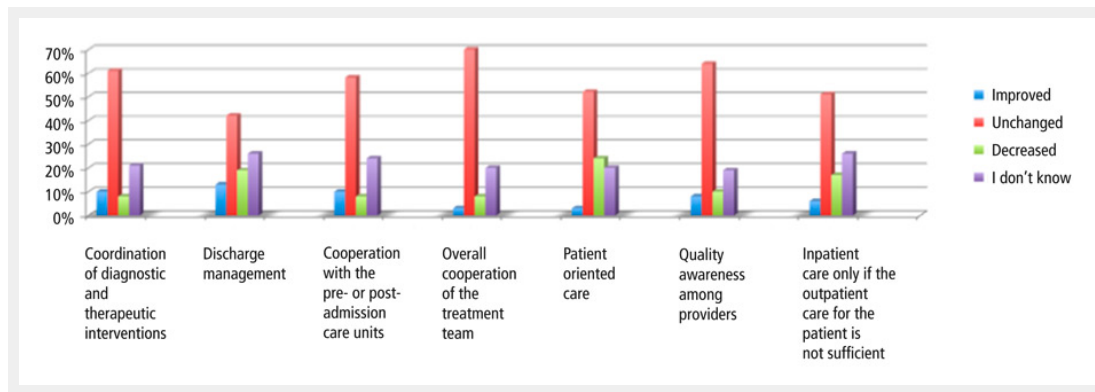
An increased focus on efficiency: change of items.